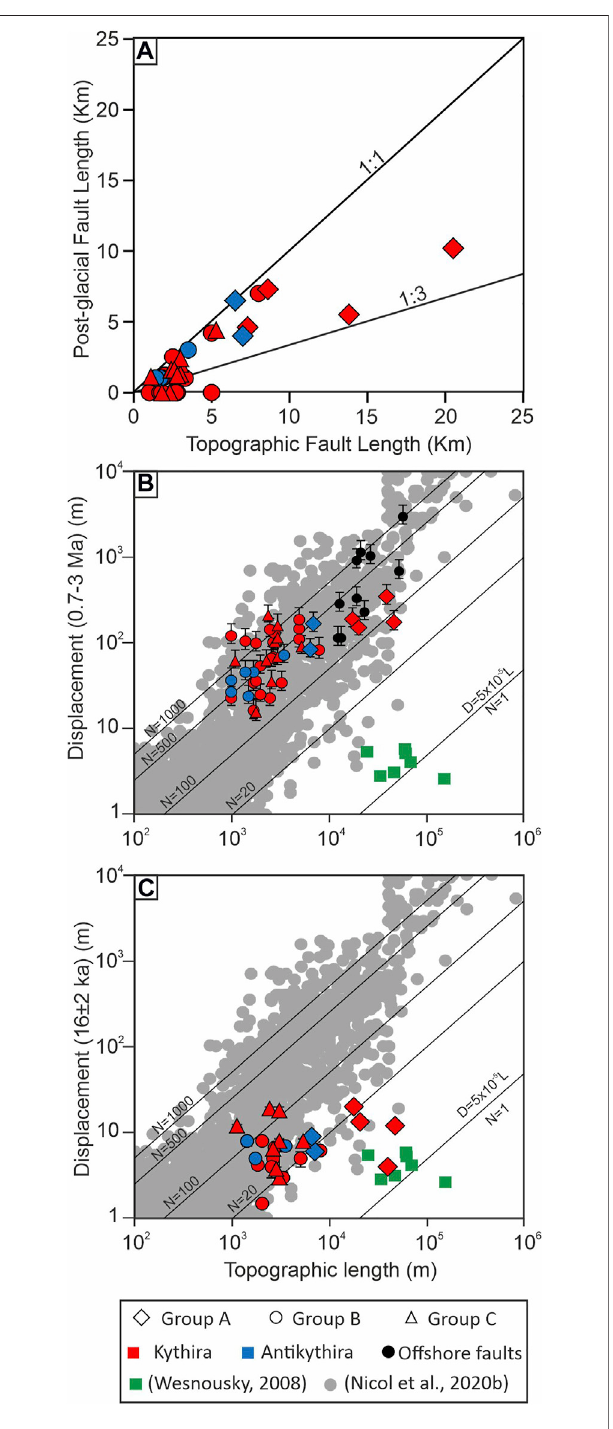
FIGURE5|(A) Plotillustratingtherelationshipbetweenthetopographicfault lengthand thepostglacialfaultlength. (B)